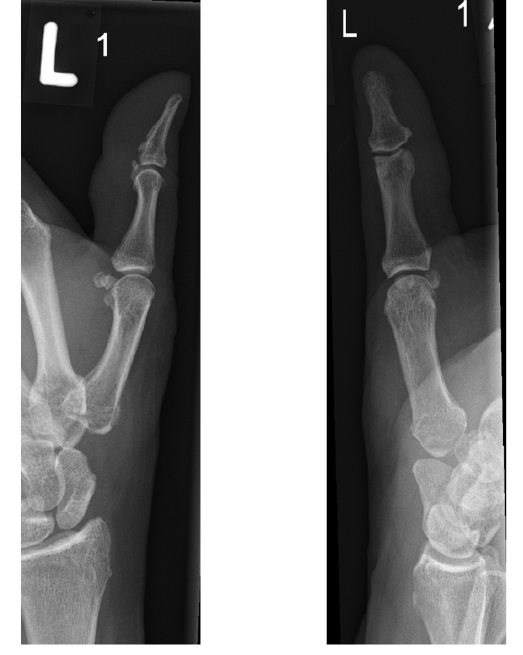
Figure 4: Left thumb after trapeziectomy with ligament reconstruc- tion and tendon interposition. Lateral view (left) and anterior-poste- rior view (right). After complete resection of the trapezial bone, the height of the thumb is preserved by filling the trapezial space with the partially resected flexor carpi radialis tendon. This resection- tendon-interposition and suspension arthroplasty is used by many hand